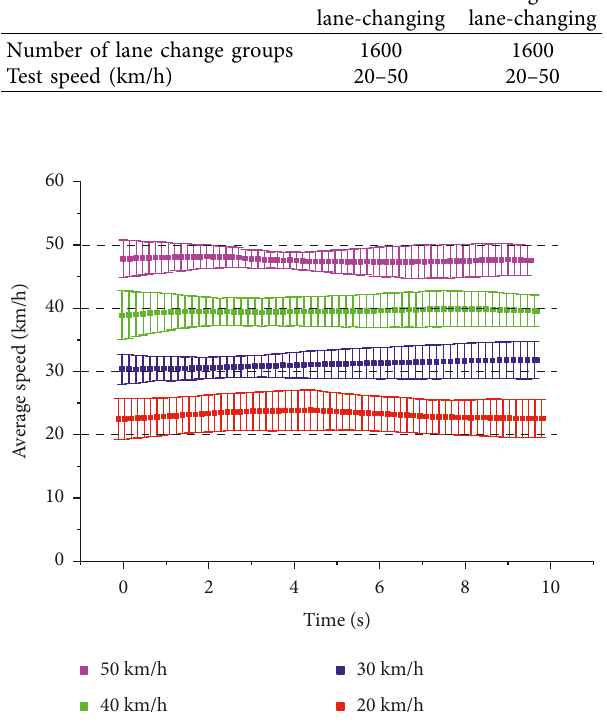
Figure 3: Average speed and average SD of skilled